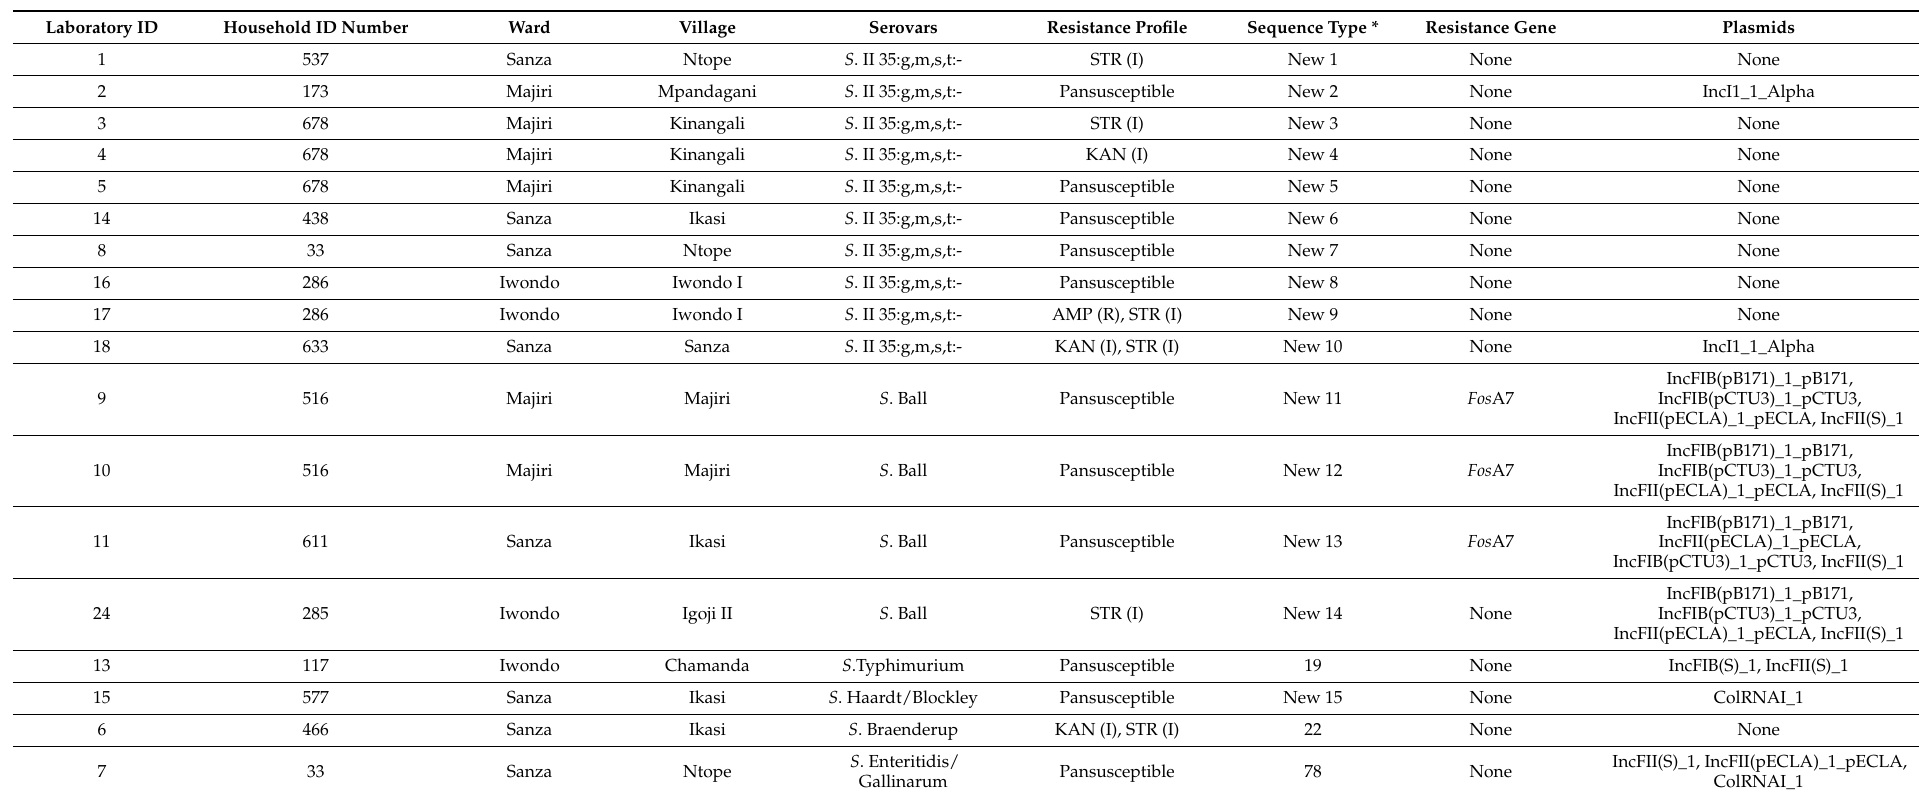
Table 4. Salmonella serovars isolated from chicken cloacal swabs, identified by whole-genome sequencing indicating the laboratory and household identification numbers, the ward and village of isolation, the sequence types *, antimicrobial resistance genes, and plasmid